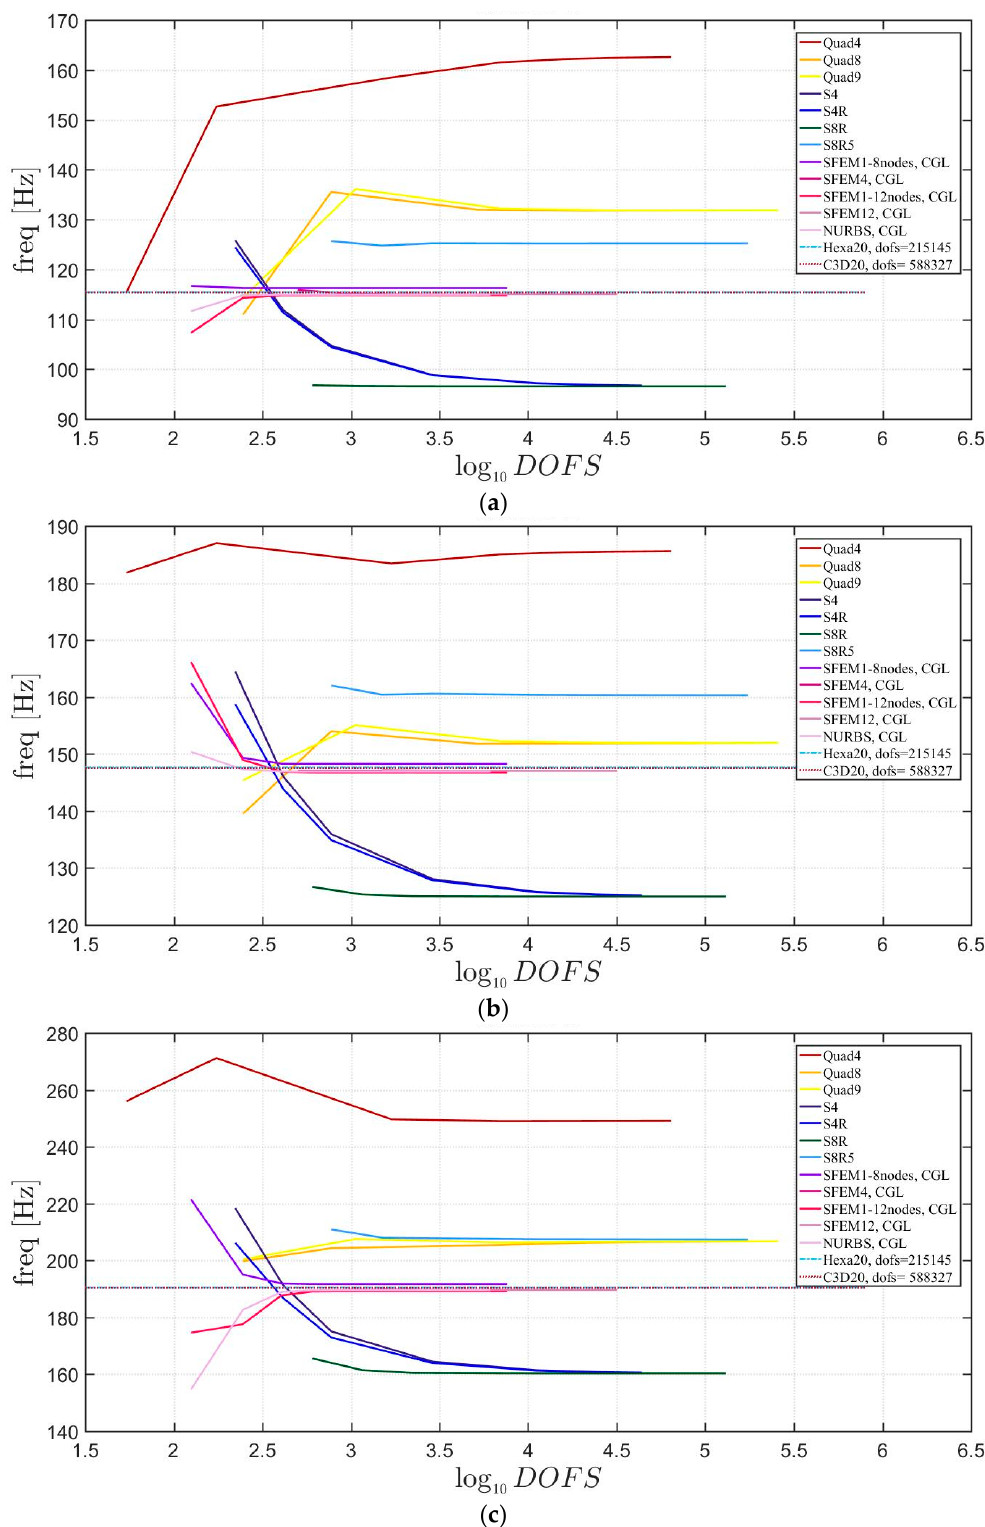
Figure 30. First three natural frequencies of an elliptic plate with a / b = 2 a not-symmetric lamination scheme and a / h = 10: ( a ) First frequency; ( b ) Second frequency; ( c ) Third frequency.